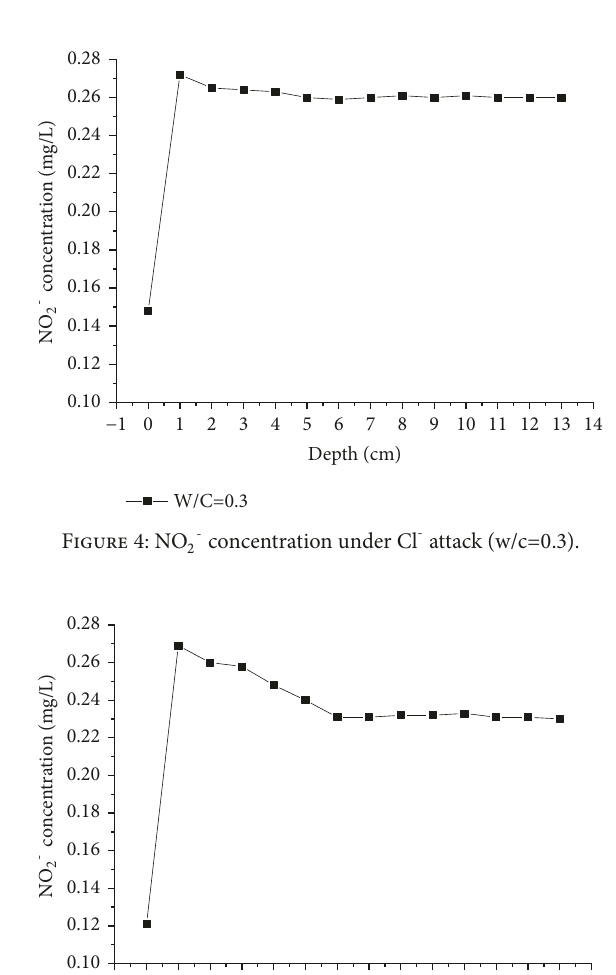
Figure 3: XRD of cement paste with 2.0% NO 2 - .